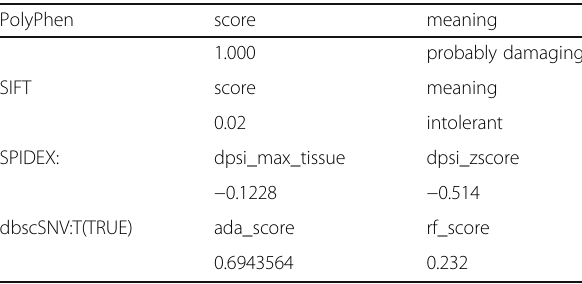
Table 2 In Silico Prediction of c.139G > C of GJA8 and